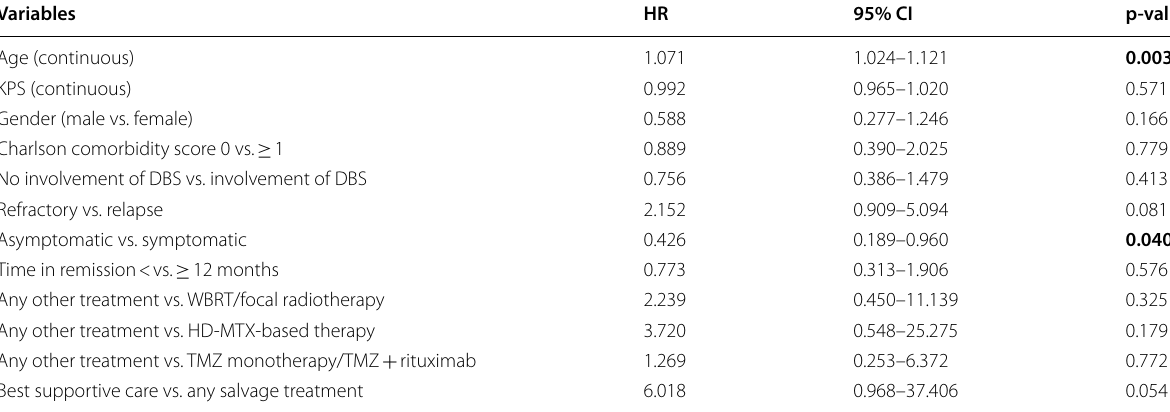
Table 2 Multivariate analysis of prognostic factors for OS after cerebral relapse (n